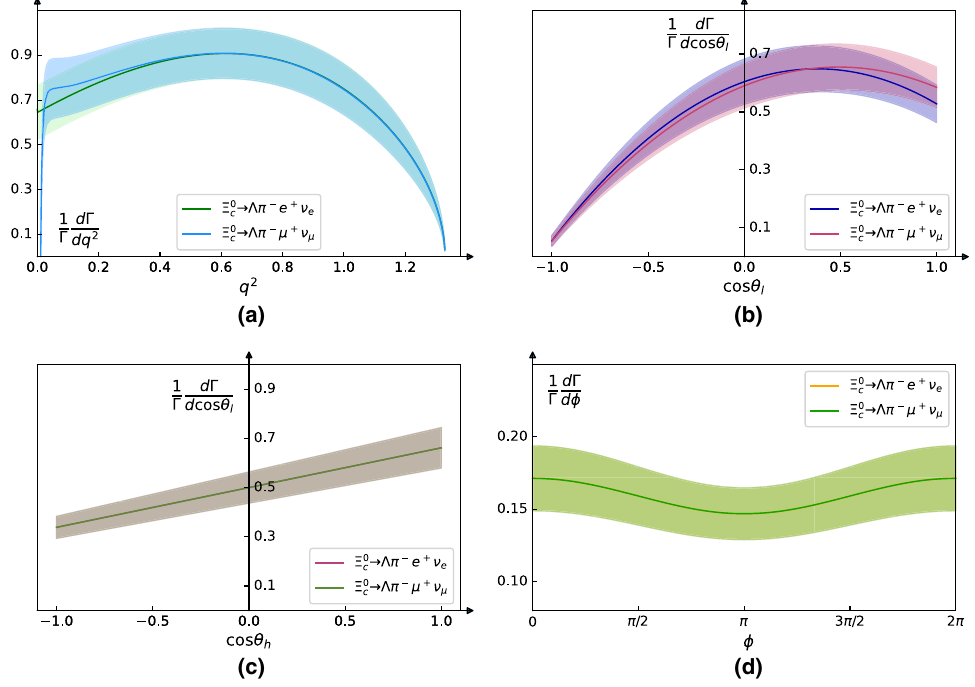
Fig. 4 Differential decay width for (cid:5) 0 c → (cid:4)π − (cid:2) + ν (cid:2) as a function of q 2 ( a ), cos θ l ( b ), cos θ h ( c ), and φ ( d ). Note that in b and c , the errors increase with θ l from − 1 to 1 and θ h from 1 to − 1, as a result of the remarkable uncertainties of form factors at the small- q 2